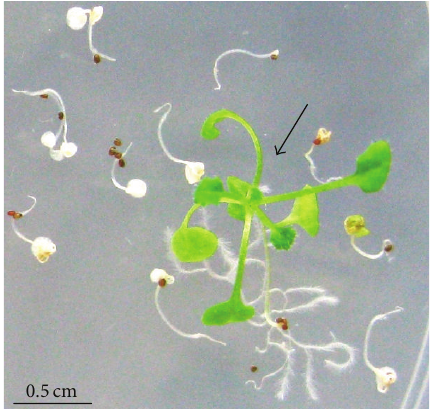
Figure 5: Comparison of hygromycin-sensitive and hygromycin- resistant (shown in arrow) seedlings. The seedlings were screened for 20 days on selection plate containing MS media supplemented with 25 mgL −1